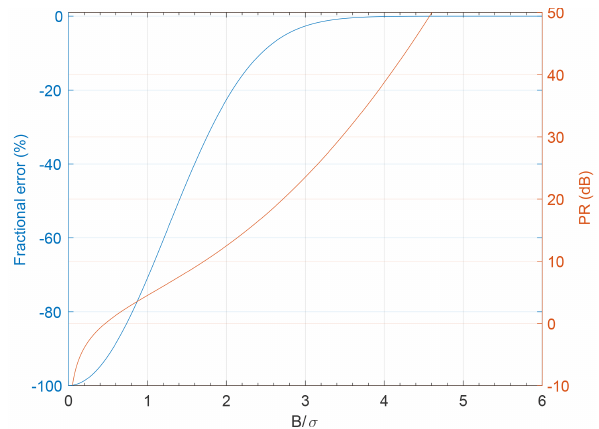
Figure A1. Left blue axis: fractional error of variance from Eq. (A4) as a function of B/σ . Right red axis: ratio of observed power to power at noise level integration limits, PR, from Eq. (A6), as a func- tion of B/σ